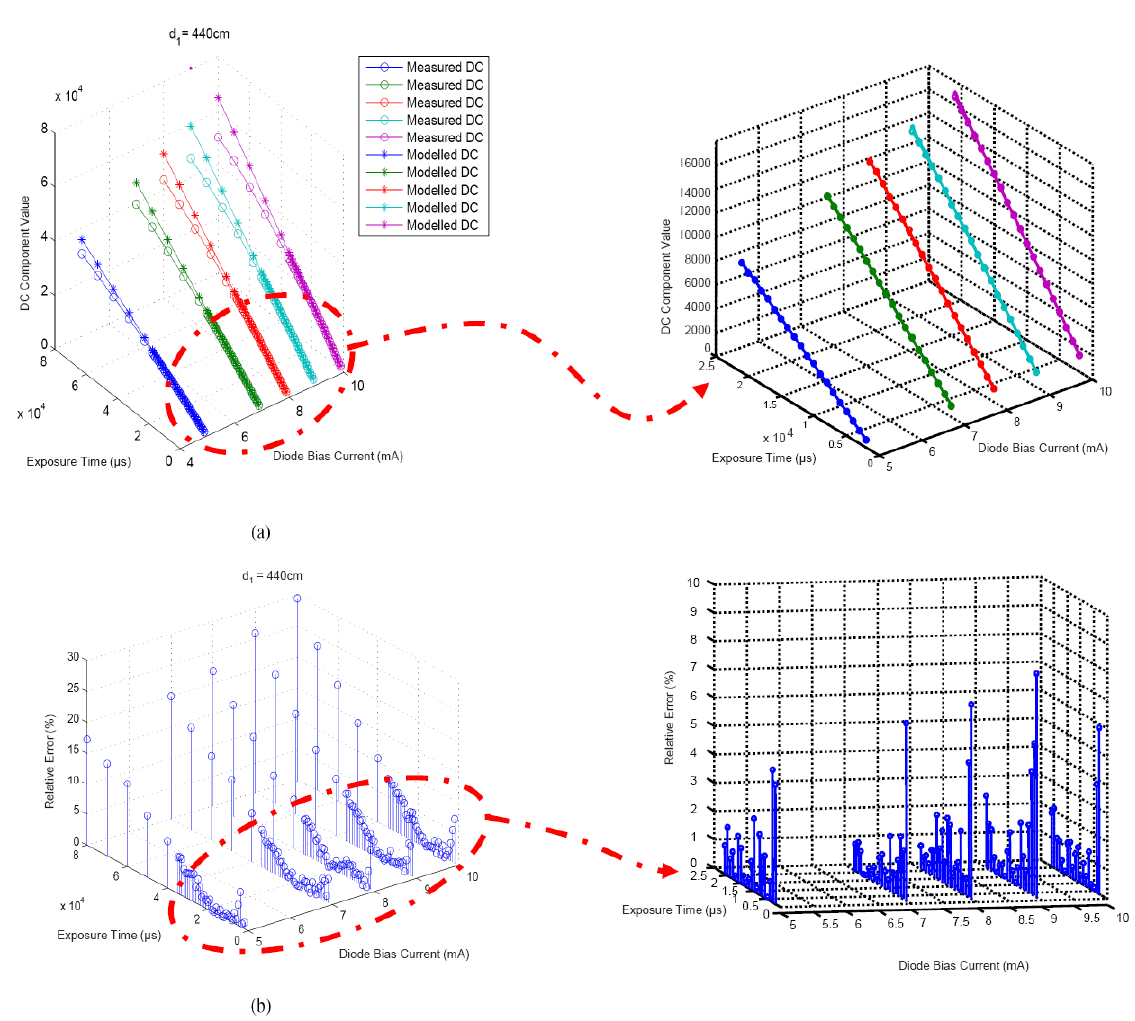
Figure 6 . Results for the calibration process. (a) Model performance. (b) Relative error in the calibration